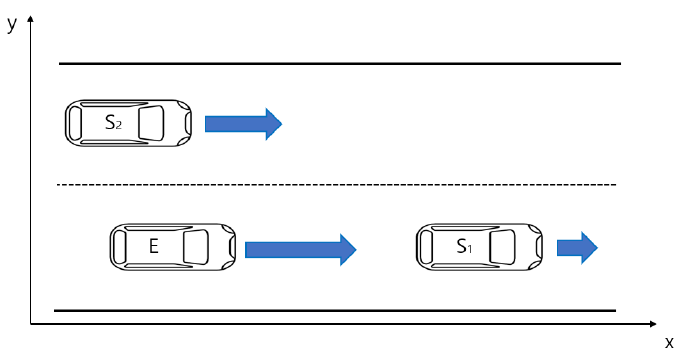
Figure 1. Autonomous driving